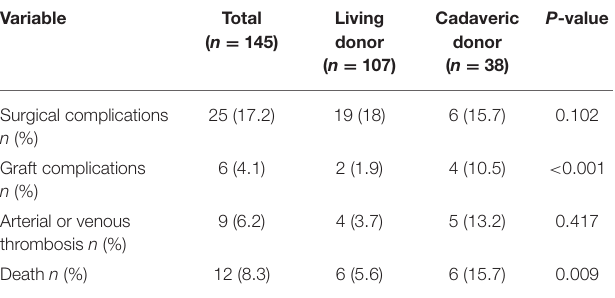
TABLE 2 | Distribution of clinical outcomes in the study population according to type of